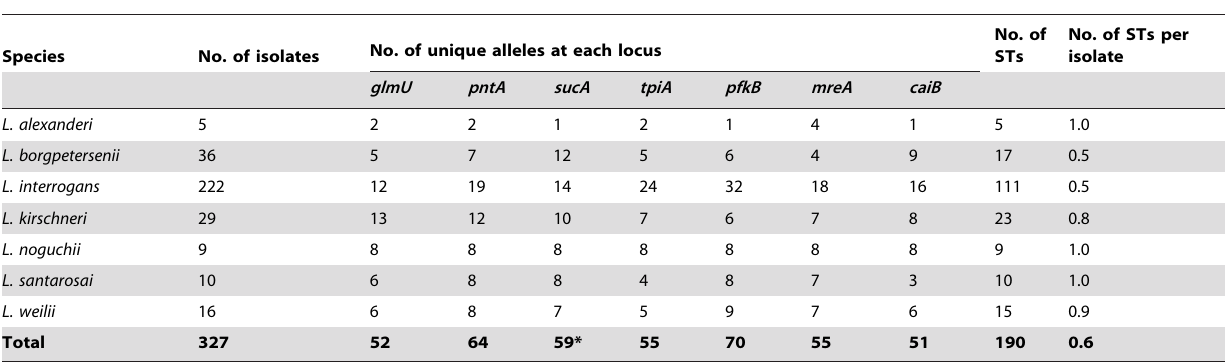
Table 2. Number of alleles and sequence types (STs) for Leptospira